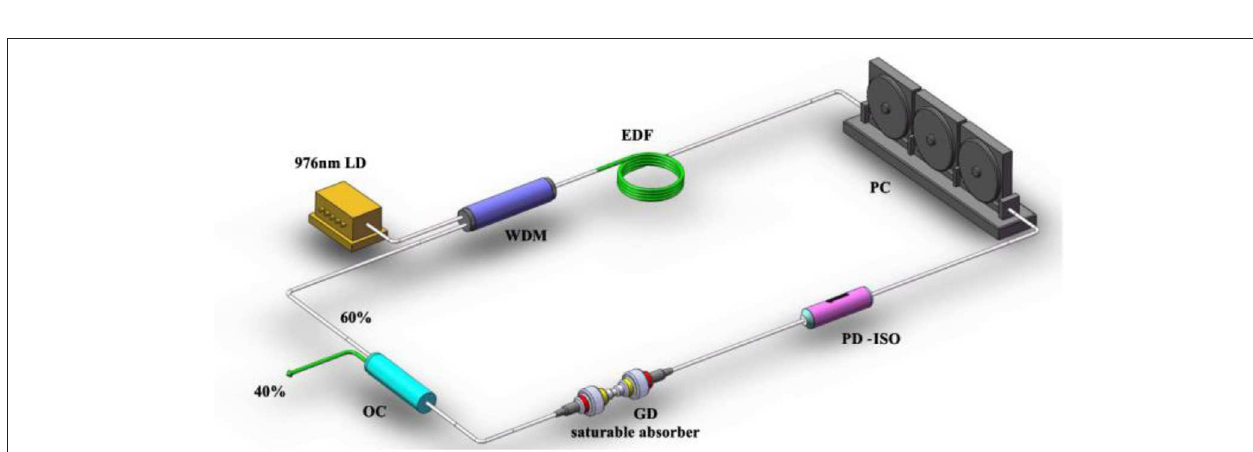
FIGURE 3 | Pulse output characteristics of NPR mode-locked laser when the pump power is 135 mW. (A) Output spectrum, (B) pulse trace on oscilloscope, (C) RF spectrum, (D) autocorrelation trace.